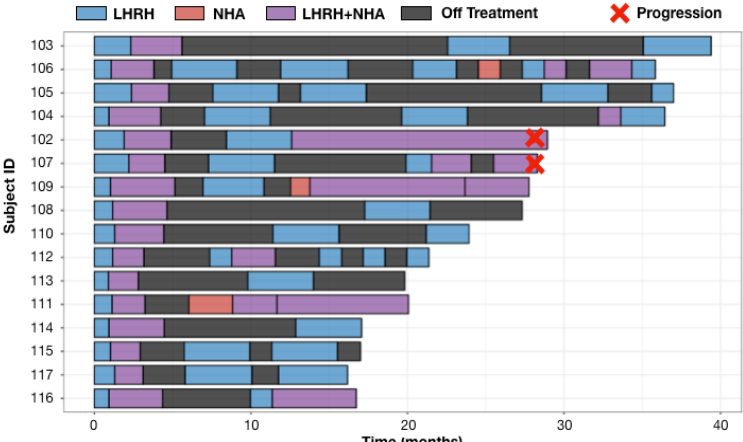
Figure 3. Swimmer Plots for 16 evaluable patients. Safety analysis included one additional patient (101) who withdrew from study treatment after refusing to restart LHRH analog at the time of his first off ADT PSA progression. Adaptive therapy was well tolerated with low frequency of all grades adverse events (AEs) regardless of the attribution. The most common Grade 1–2 treatment-related AEs were arthralgia, hot flashes, back pain and fatigue. One incidence of grade 3 hypertension was reported, which was attributed to abiraterone. All AEs were improved to baseline or resolved with recovery of testosterone while on the treatment break. There were no grade 4 AEs (Table 3). Table 3. Summary of grade 3 or 4 AEs on 17 enrolled patients.